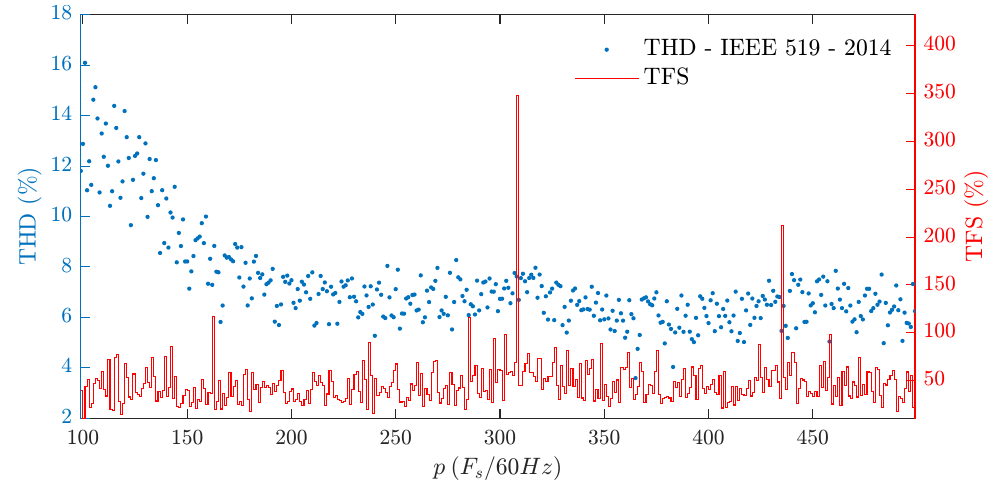
Figure 15. Sampling frequency effect in FCS-MPC using the cost function (12) ( λ = 0.005): THD and